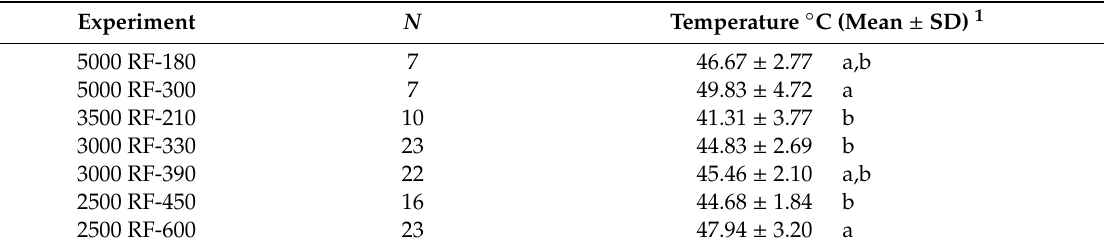
Table 3. Comparison between the maximum temperatures (mean ± Standard Deviation) of the dates at the end of RF heating with di ff erent combinations of voltage and exposure time (Kruskal-Wallis test: N = number of replicates; H (6, N = 108) = 34.41, p <